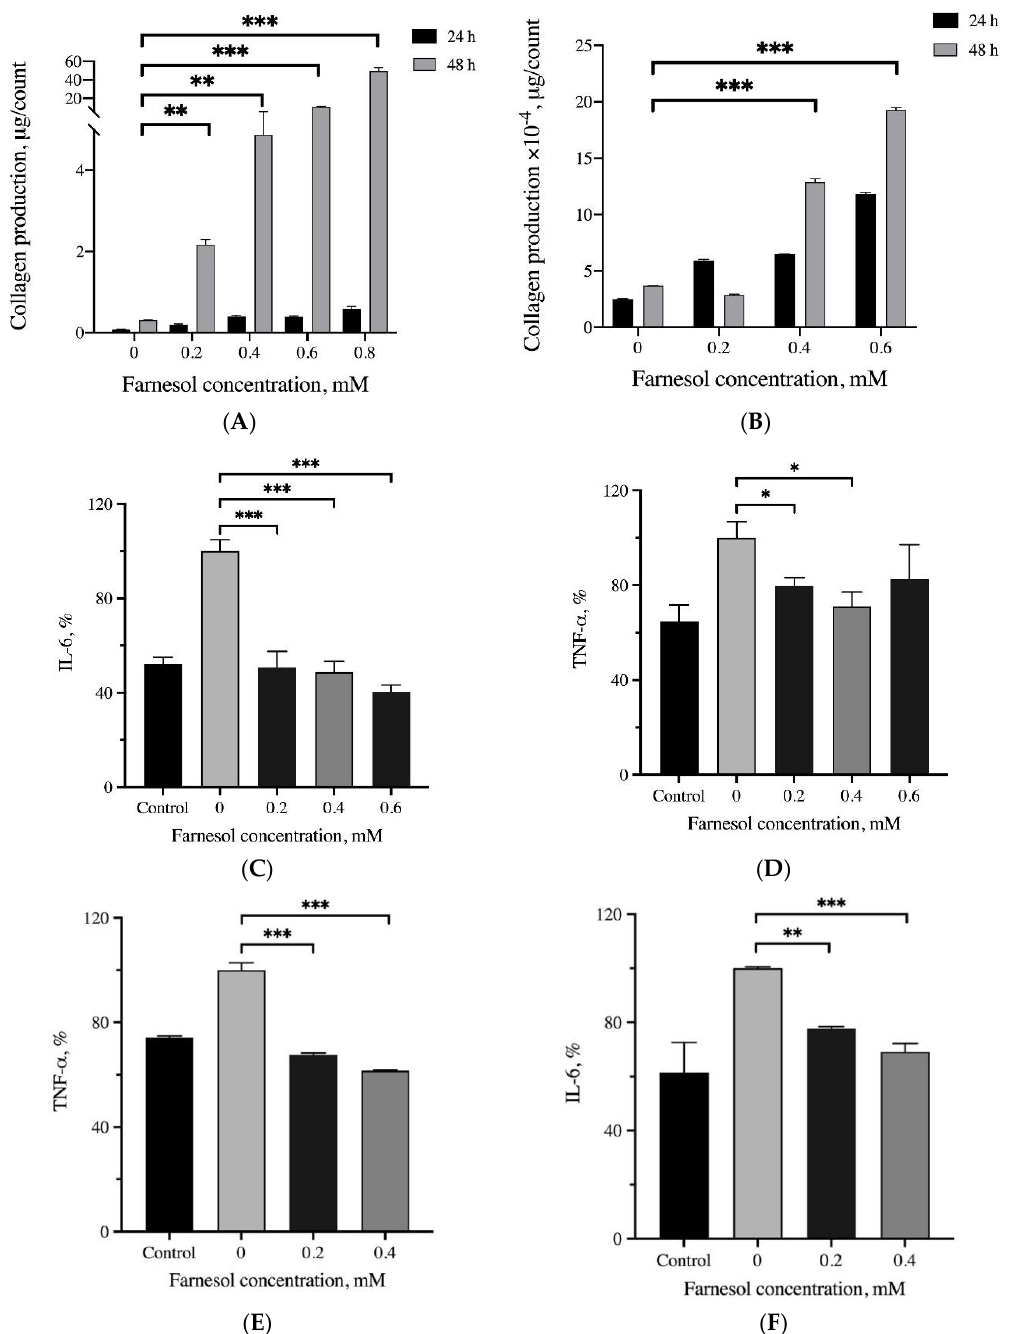
Figure 5. Effects of farnesol on collagen production in ( A ) C2C12 myoblasts and ( B ) tenocytes. Significant differences are based on comparisons with the control group after 48 h incubation (without addition of farnesol), ** p < 0.01 and *** p < 0.001. Effect of the anti-inflammatory response of farnesol induced by H 2 O 2 exposure; ( C ) IL-6 and ( D ) TNF-α expression assayed in C2C12 myoblasts; ( E ) IL-6 and ( F ) NF-α expression assayed in tenocytes. * p < 0.05, ** p < 0.01, and *** p < 0.001. IL-6: interleukin 6; TNF-α: tumor necrosis factor α.